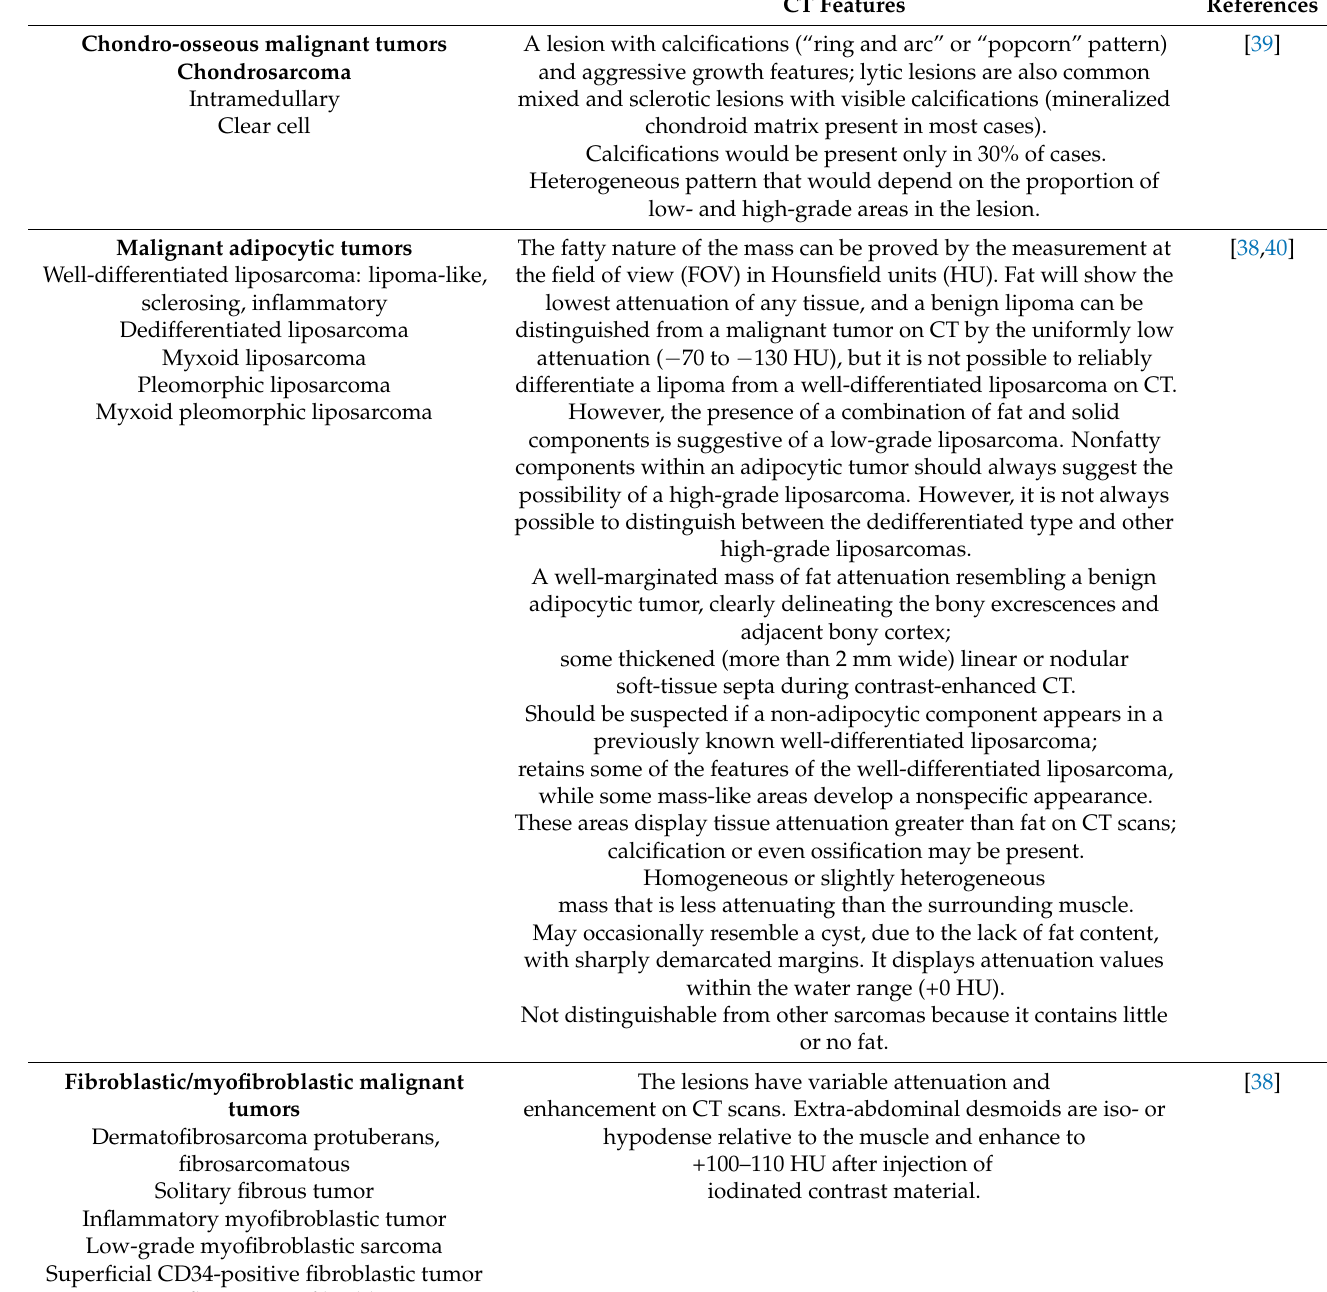
Table 1. The main CT features of STSs and bone sarcomas (based on